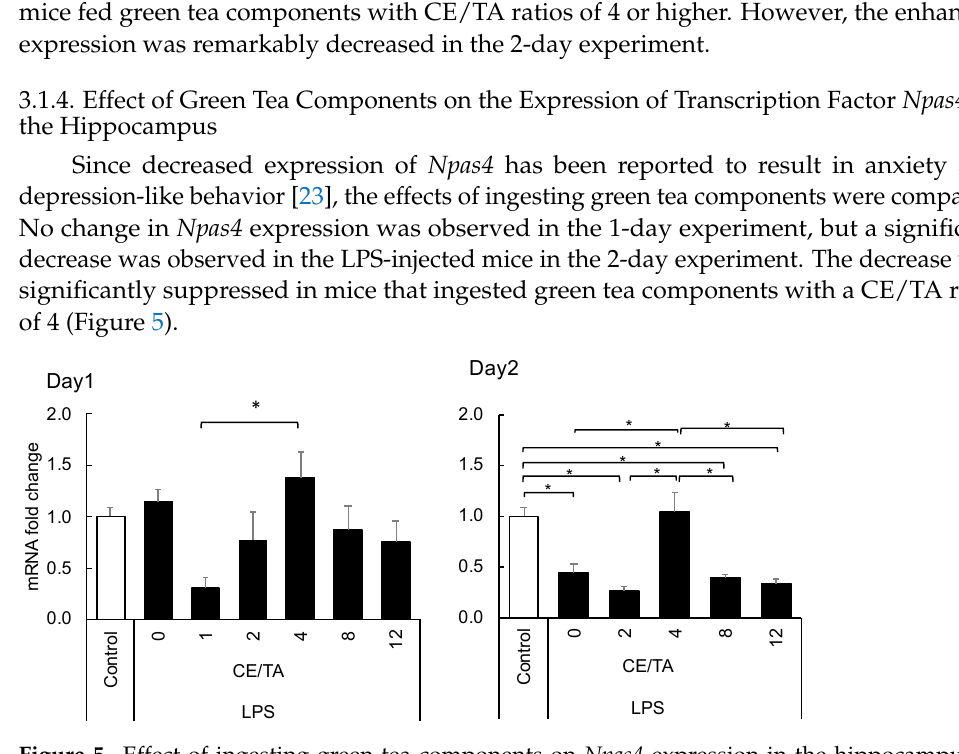
Figure 5. Effect of ingesting green tea components on Npas4 expression in the hippocampus of LPS-injected mice in 1-day and 2-day experiments. Mice ingested green tea components ad libitum for 6 days prior to LPS injection. Each value represents the mean ± SEM ( n = 8, * p < 0.05, Tukey–Kramer method).